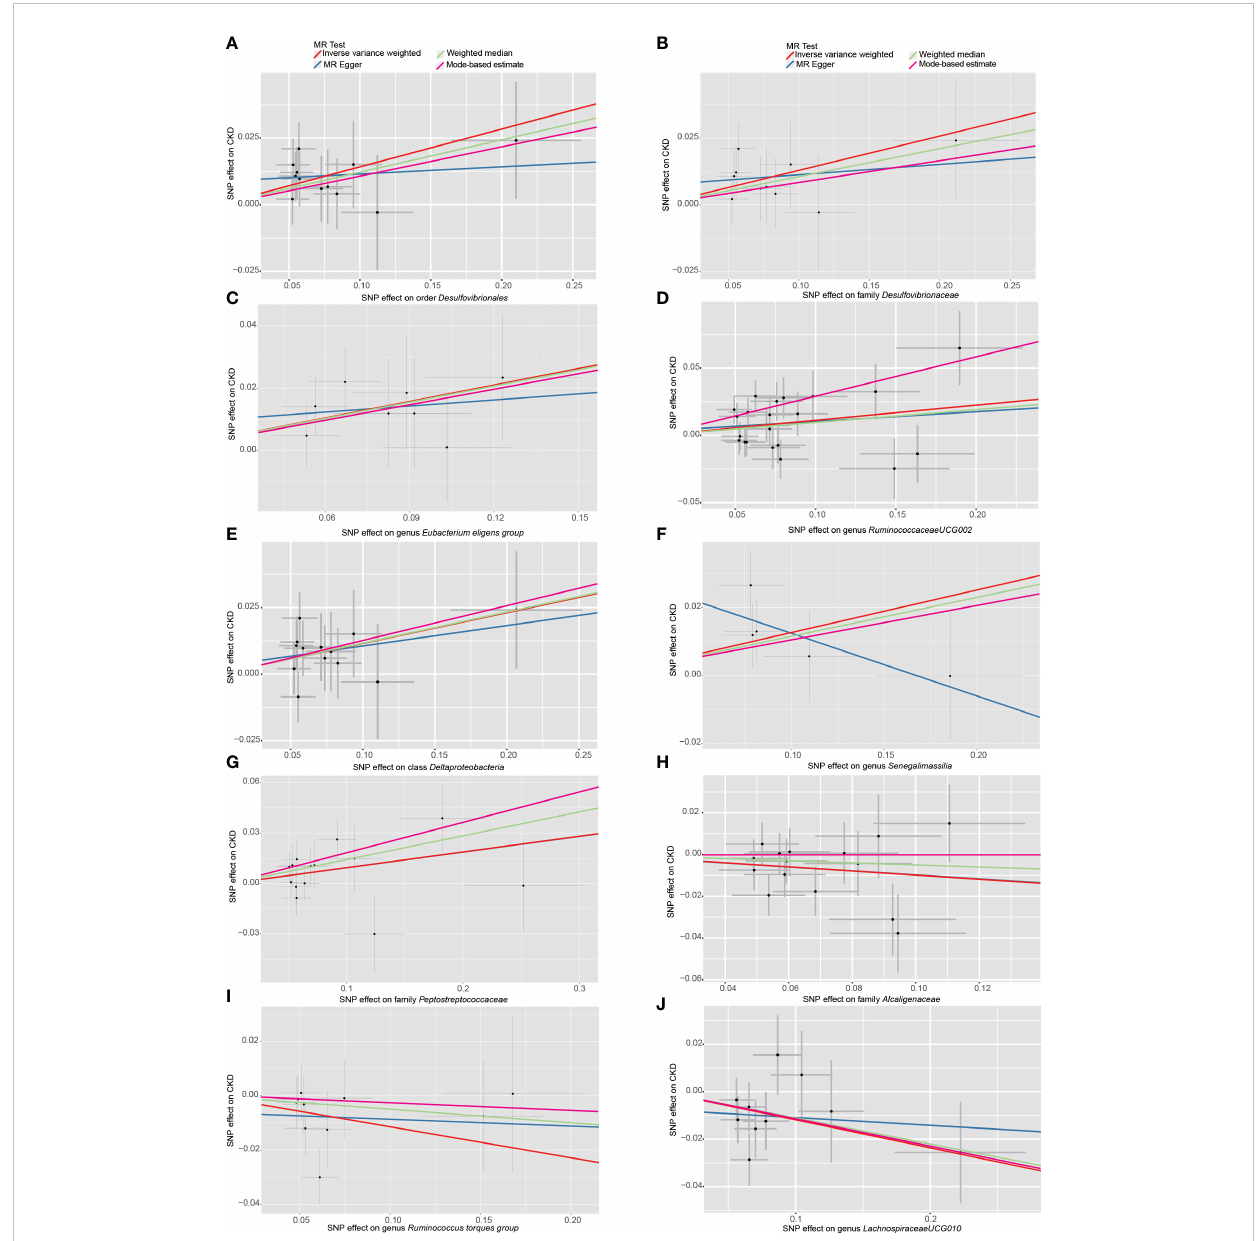
FIGURE 3 Scatter plots of the MR analyses for the association of 10 gut bacterial taxa and the risk of chronic kidney disease. (A) Causal effect of Desulfovibrionales on CKD; (B – J) Potential causal effect of nine other gut bacterial taxa on CKD. SNP, single nucleotide polymorphisms; MR, mendelian randomization; CKD, chronic kidney